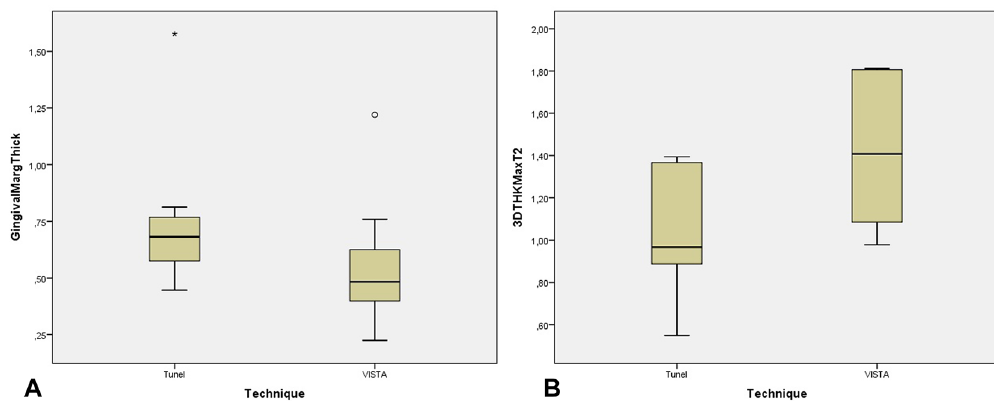
Figure 1. ( A ) Box-plot showing the gingival margin thickness (mean and interquartile range) of patients treated with the tunnel vs. VISTA techniques. Symbols (star and circle) indicate outliers of the study sample. ( B ) Box-plot showing 3DTHKMax T2 (mean and interquartile range) for patients treated with the tunnel vs. VISTA techniques.